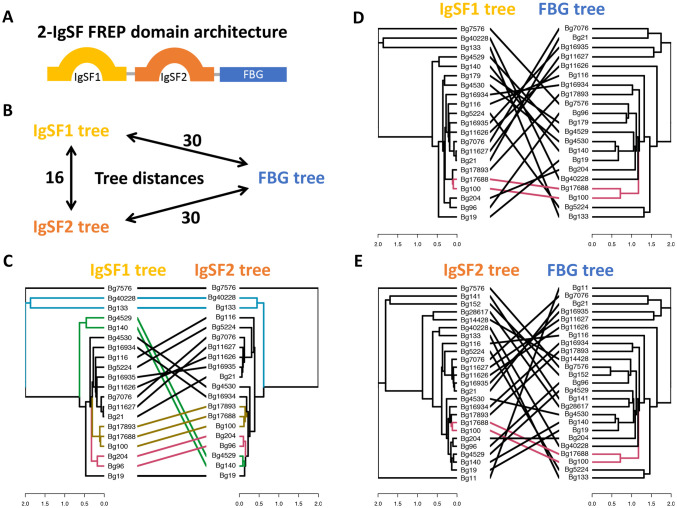
Domain tree comparisons of IgSF1, IgSF2 and FBG domains from complete 2-IgSF FREPs in B. glabrata. A.Domain structure of 2-IgSF FREPs; B. Tree distances were measured by Robinson-Foulds or symmetric distance among trees of IgSF1, IgSF2 and FBG domains from 2-IgSF FREPs; C. Tanglegram plot of a side by side ML (Maximum Likelihood) trees for IgSF1 and IgSF2 domains from 2-IgSF FREPs; D. Tanglegram plot of ML trees for IgSF1 and FBG domains from the 2-IgSF FREPs; E. Tanglegram plot of ML trees for IgSF2 and FBG domains from the 2-IgSF FREPs. The colored connection lines in 6C, 6D and 6E highlighted some common subtrees.